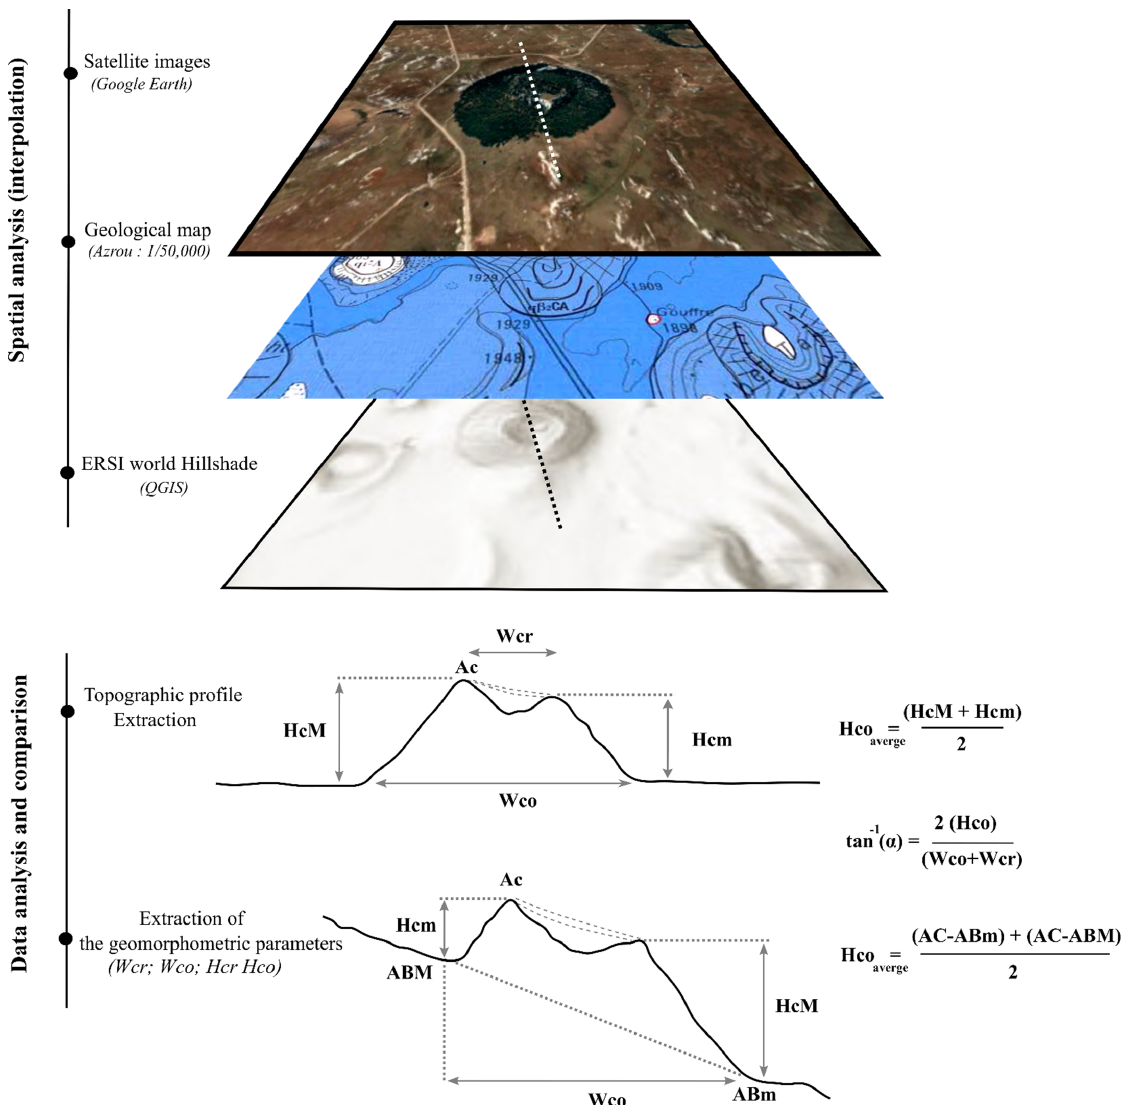
Figure 3. Methods to calculate Hco, Wco, and S° of scoria cones. Following the method of Dóniz-Páez et al. [83] , where HcM is the maximum height, Hcm is the minimum height, ABm is the minimum altitude of the base, ABM is the maximum altitude of the base, and AC is the altitude of the top of the cone. The calculation of the slope ( α ) is performed according to the approach of Hasenaka and Carmichael [84] .